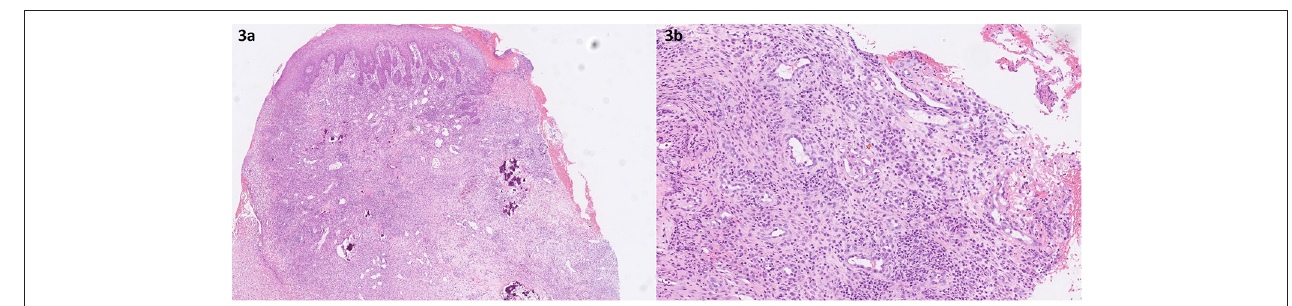
FIGURE 3 | Histopathology of the biopsy specimens taken from the lower jaw (first biopsy). (a) Inflamed gingival mucosa with superficial erosions, with granulation tissue and dystrophic calcifications. Retrospectively, calcifications were “reinterpreted” as remains of destructed alveolar bone. HE, original magnification, × 4. (b) Recanalization of the small vessels in the inflamed gingival mucosa (mark). Note the intense mixed inflammatory infiltrate in the background and the swollen endothelial cells. HE, original magnification, × 20.